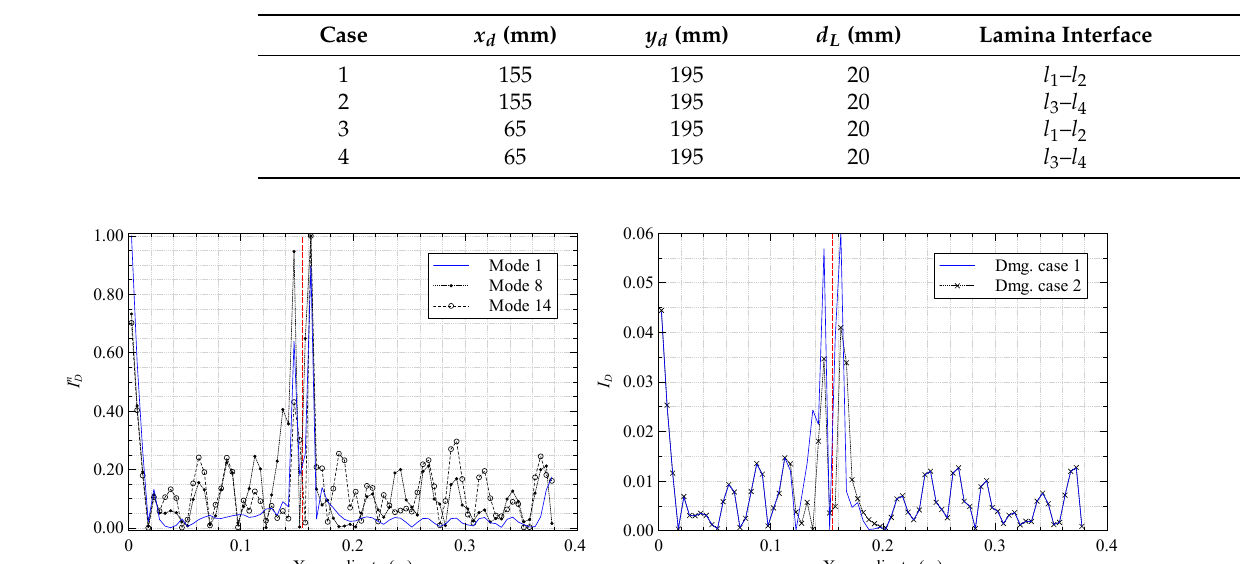
Table 2. Details of the four delamination cases analyzed